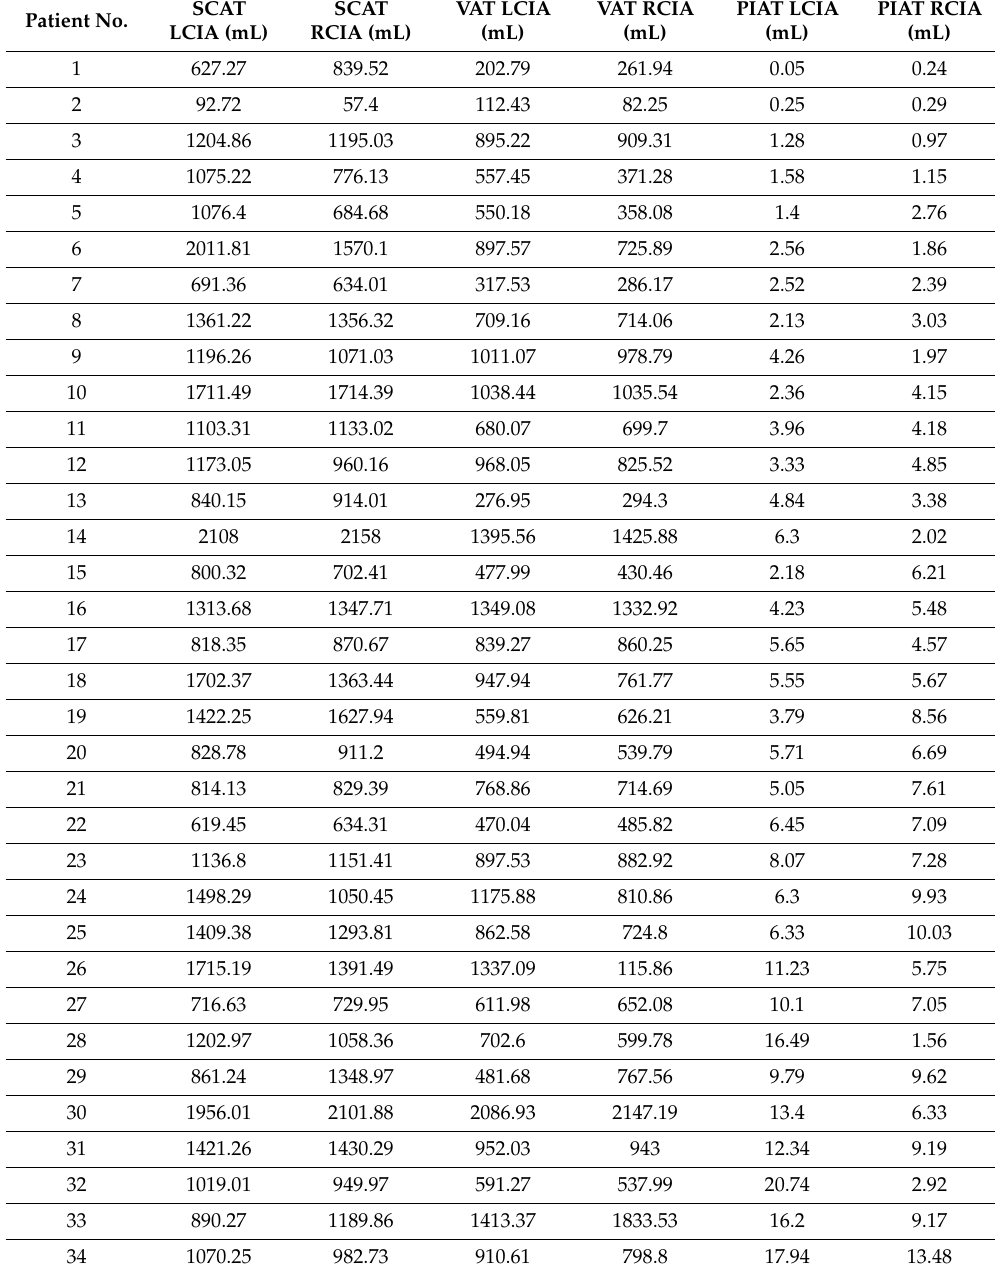
Table 3. Subcutaneous, visceral and periiliac fat measured at di ff erent levels of the iliac arteries, at the RCIA and